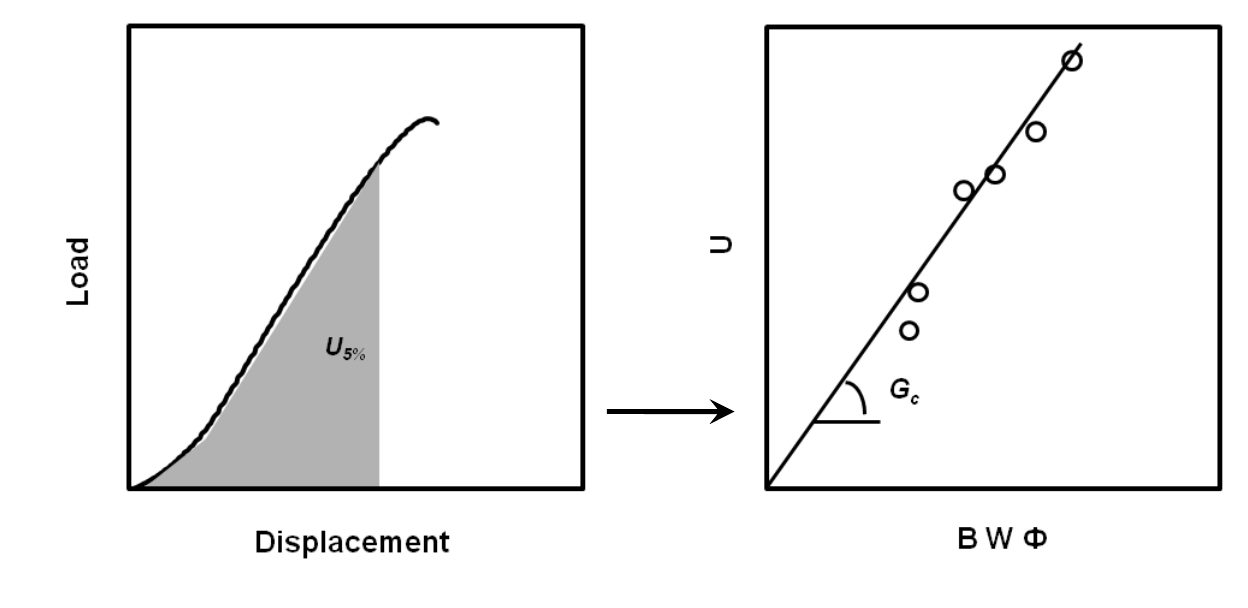
Figure 11. Determination of the critical strain energy release rate, G experimental load-displacement